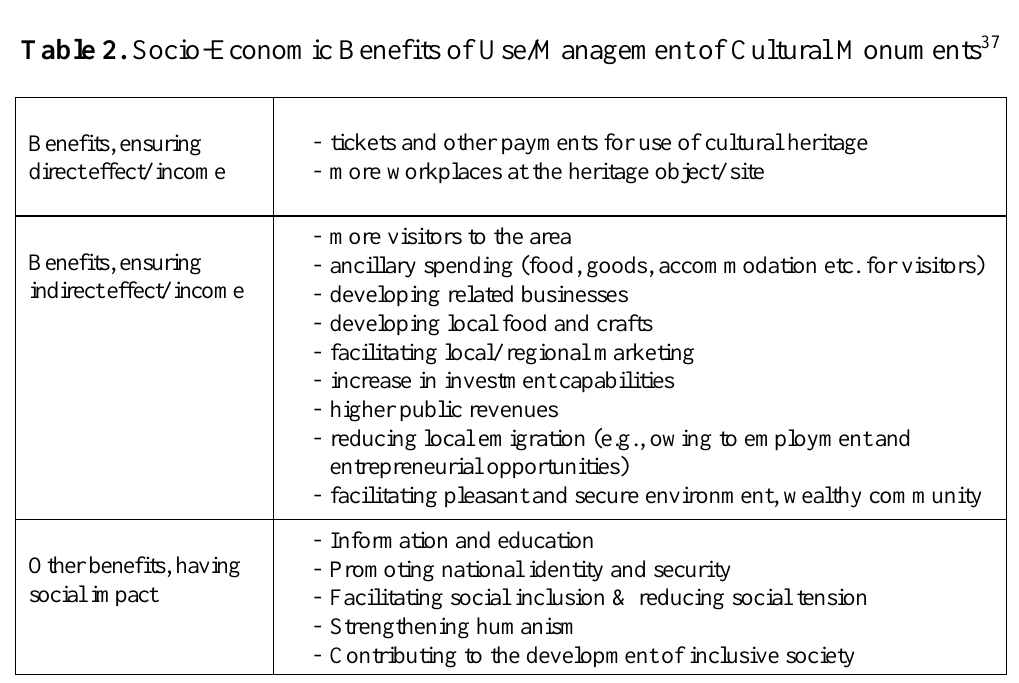
Table 2. Socio-Economic Benefits of Use/Management of Cultural Monuments 37